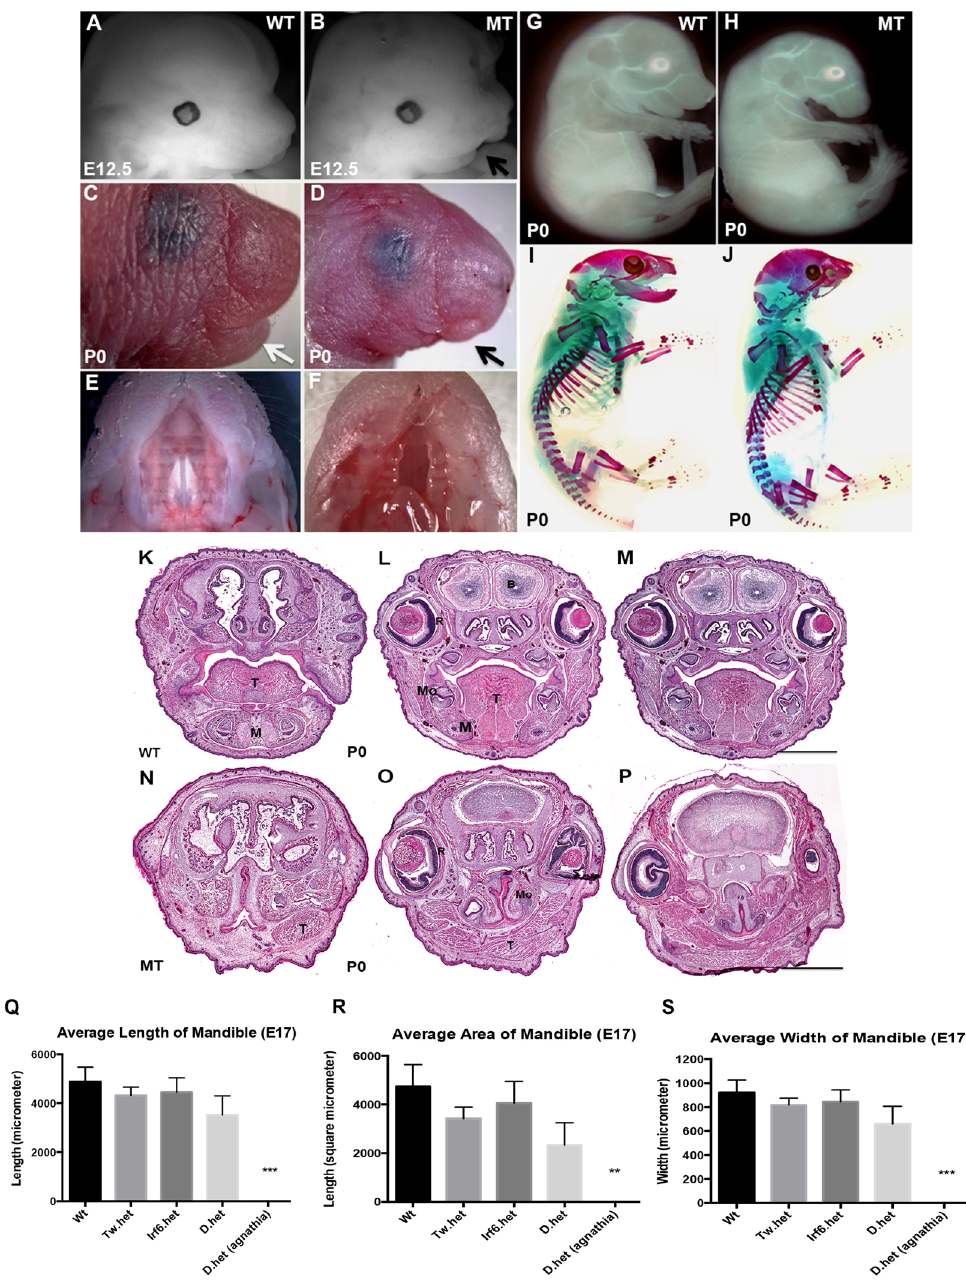
Figure 1. Craniofacial abnormalities in Irf6 and Twist1 double heterozygotes murine animals and morphometric measurements of embryonic mandible. Compared to wild type murine embryo ( A ), littermate mutant embryo of double het ( B ) has a short mandibular prominence start at E12.5. At P0, mutant pup has lower jaw abnormalities ( C versus D ), and complete cleft of the secondary palate ( E versus F ). Phase contrast images show mutant embryo with absent lower jaw and low-set ear ( H ) but grossly normal body ( G versus H ). Skeletal preparations show that the mutant pup is missing a mandible and has abnormalities in inner ear bones ( I versus J ). Hematoxylin and eosin staining of coronal sections of heads from wild type ( K – M ) and double heterozygous affected murine pups ( N – P ), from anterior ( K , N ), middle ( L , O ) to posterior ( M , P ). Relative to wild type littermate (WT), mutant (MT) has cleft palate, malformed tongue, detached retina and holoprosencephaly ( O , P ). Tongue (T), mandible ( M ), molar tooth germ (Mo), retina (R), brain (B). Scale bars = 1000 μ m. Figures ( Q , R and S ) are average length, width and area of murine mandibles of different genotypes at E17.5. A total of 28 craniofacial skeletons of murine embryos were used to calculate the averages. The black bars represent standard error for each genotype. Average mandibular lengths of murine embryos of all different genotypes ( Q ). Average mandibular widths of murine embryos of all different genotypes ( R ). Average mandibular area of murine embryos of all different genotypes ( Q ). The average area of Irf6 , Twist1 double hets vs. wild type is smaller relative to mean area of wild types, but the difference is not statistically significant using the multi-variants ANOVA test. Wild type (WT), Twist1 heterozygous (Tw.het), Irf6 heterozygous (Irf6.het) and double heterozygous